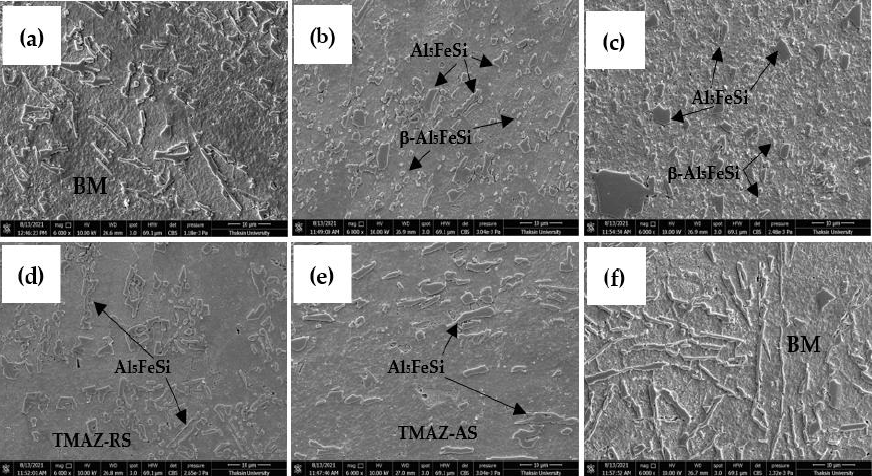
Figure 12. The characteristics of the Al 5 FeSi intermetallic compound evaluation by SEM (6000×) of the optimal welding conditions of MOVaNSAS: ( a , f ) BM, ( b , c ) SZ, ( e ) TMAZ-AS, and ( d ) TMAZ-RS.